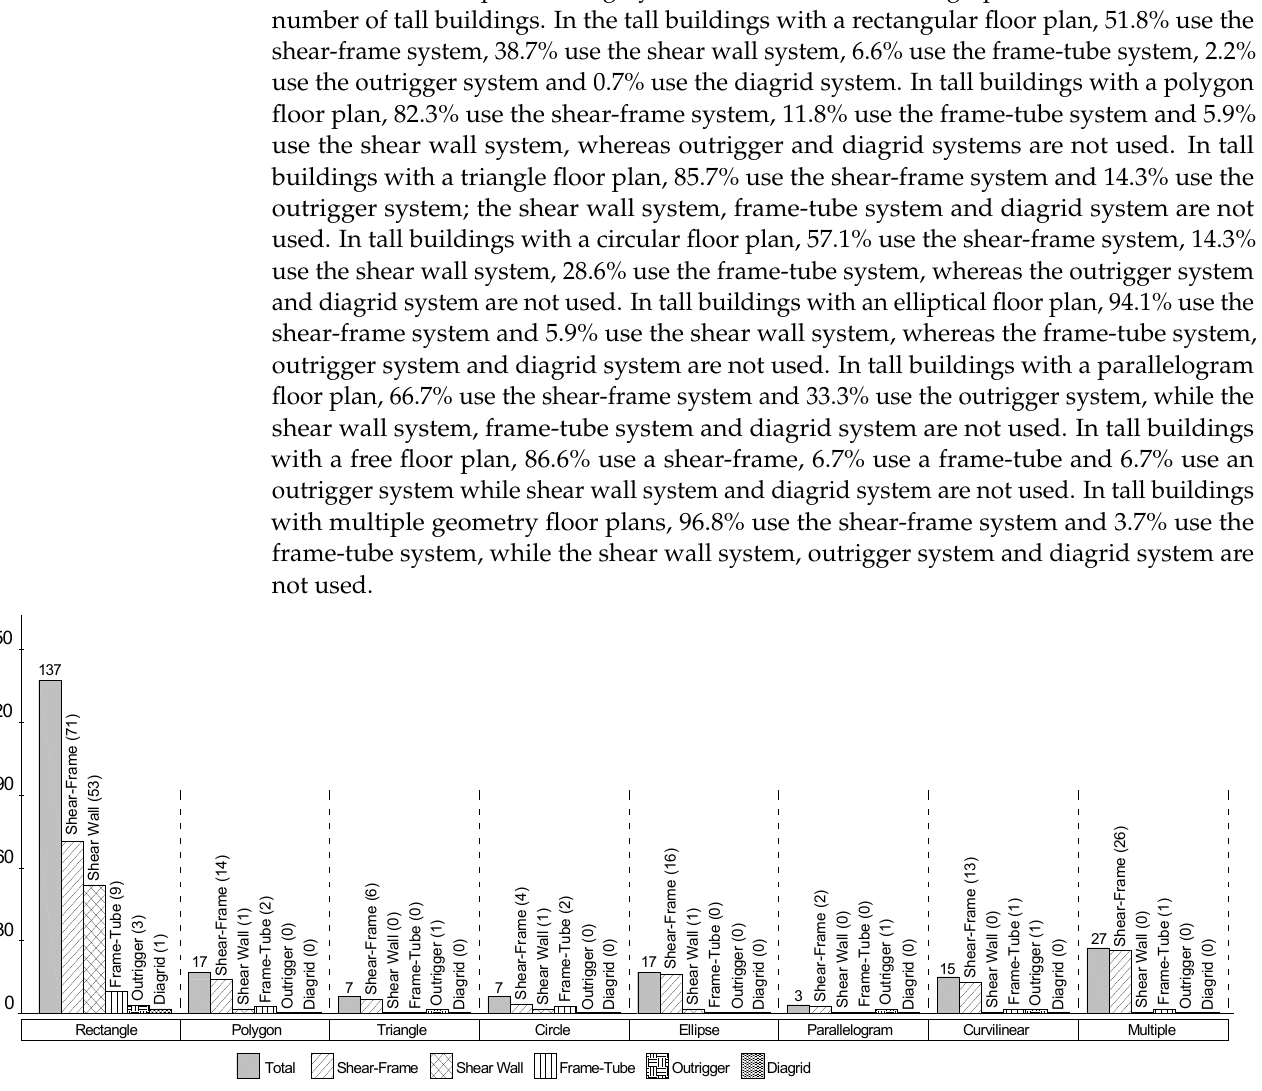
Figure 15. Relation between floor plan and structural system.